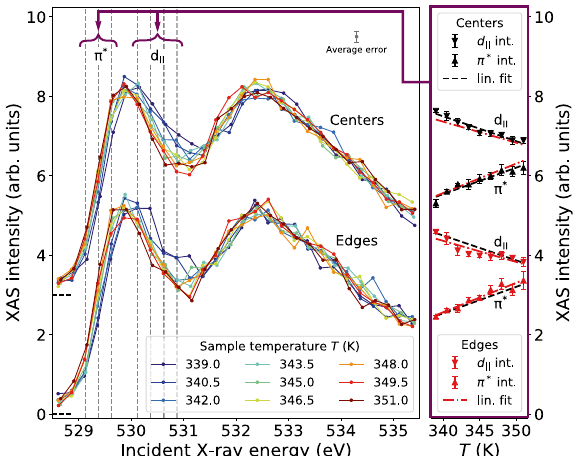
Figure 2. Left panel: Partial fluorescence yield oxygen K -edge X-ray absorption spectra from center (top) and edge (bottom) regions averaged over five VO 2 microsquares for temperatures ranging from 339 to 351 K. The average standard deviation for a single data point is displayed in the upper right corner. Vertical grey dashed lines indicate the energies which were chosen for extraction of the metallic fraction (see main text and Fig. 3). Right panel: Mean intensities in the π ∗ and d || spectral regions show the IMT progression. Within each spectral region, black and red triangles respectively show the average intensity for the spectra from centers and edges. Additionally, linear fits to the intensity trends of the centers and edges are shown as guide to the eye using black, dashed and red, dash-dotted lines, respectively. Error bars show the one-sigma standard deviation of intensities of the five VO 2 microsquares in each energy region. In both panels, data for the center regions have been shifted up by three units for